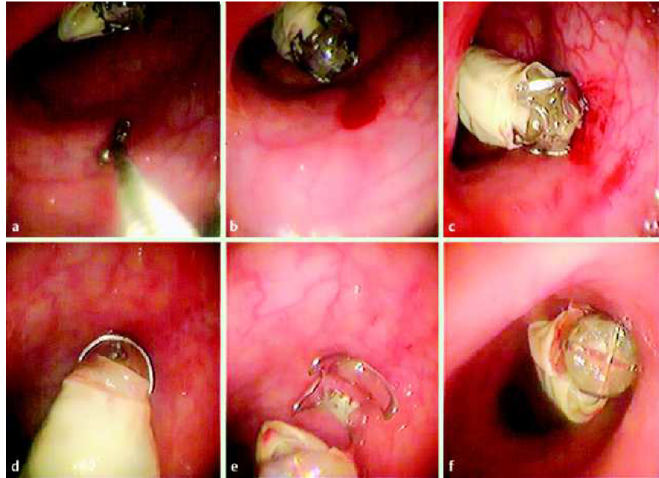
Figure 11. Wireless hemostatic endoscopic capsule. ( a ) Induced bleeding using a biopsy catheter; ( b ) the capsule approaching the bleeding lesion; ( c ) position adjustment using magnetic force; ( d ) capsule before the release of the clip; ( e ) deployment of the clip; ( f ) capsule without the clip. Adapted from Valdastri et al. [72] with permission from Thieme.